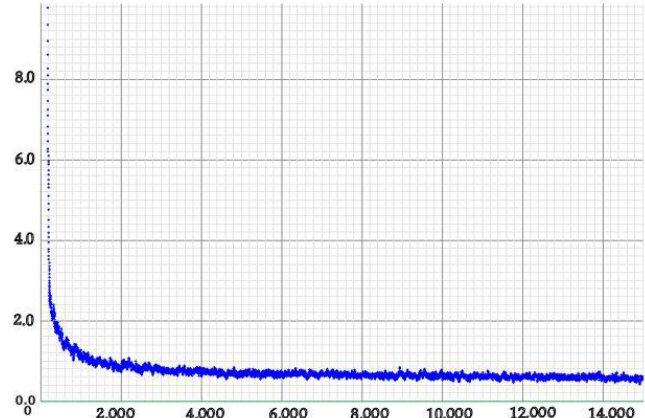
Figure 13. The average loss graph during training the network.